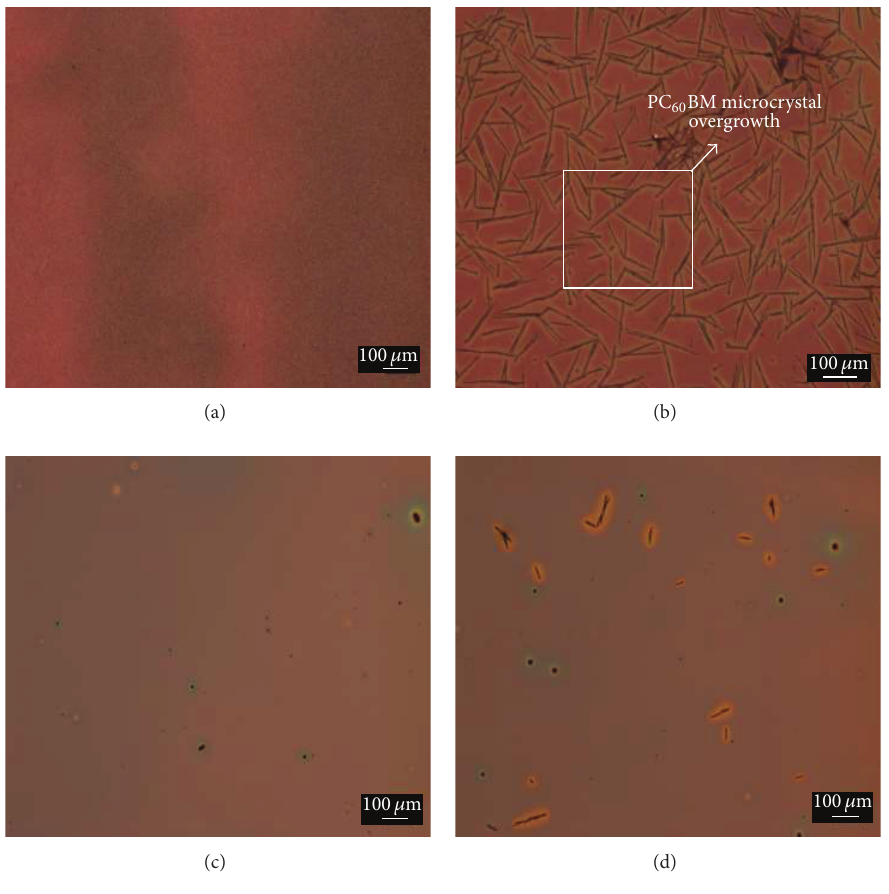
Figure 6: Optical microscope images, scale 100 𝜇 m: (a) ITO \ PH500 \ P3HT:PC 60 BM (pristine) unannealed, (b) ITO \ PH500 \ P3HT:PC 60 BM (pristine) annealed, (c) ITO \ PH500 \ P3HT:PC 60 BM layer (with 30 vol% glycerol additive) unannealed, and (d) ITO \ PH500 \ P3HT:PC 60 BM (with glycerol 30vol% additive)